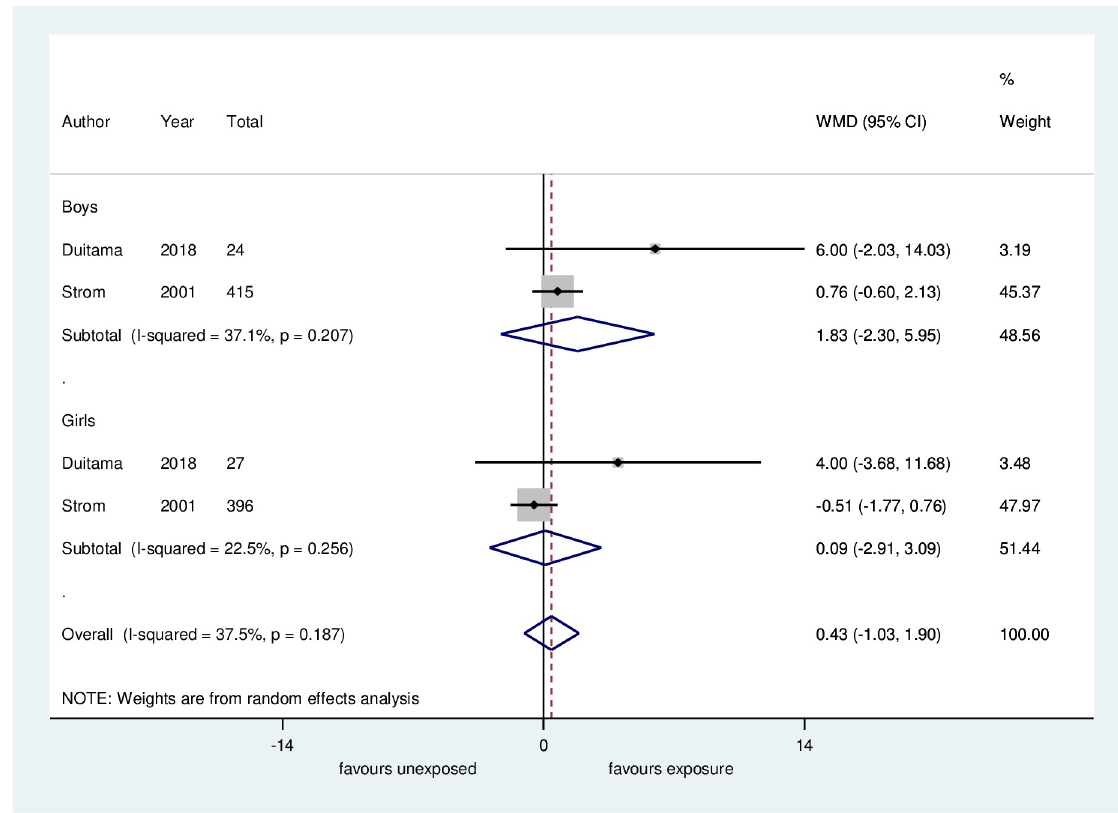
Fig 4. Meta-analysis of height in the final follow-up: Soy-based diet versus non-soy-based diet. WMD: Unstandardized mean difference. In the Duitama study height was measured at the beginning of puberty, and in the Strom study height was measured as an adult.